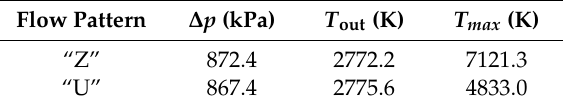
Figure 9. Temperature field of the two PBRs using di ff erent flow patterns. ( a ) “Z” flow pattern; ( b ) “U” flow pattern. Table 3. Thermal hydraulic characteristics of the two PBRs using di ff erent flow